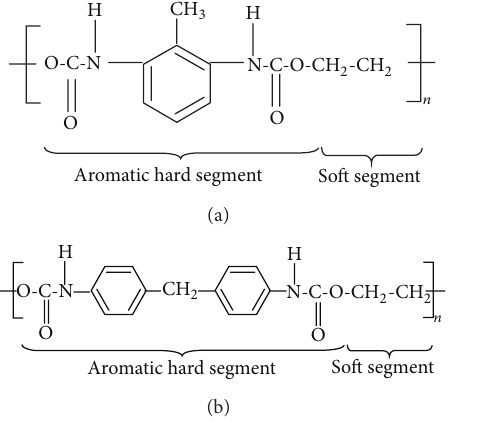
Figure 7: Chemical polyurethane zones, soft and hard segments: (a) TDI, (b) MDI.